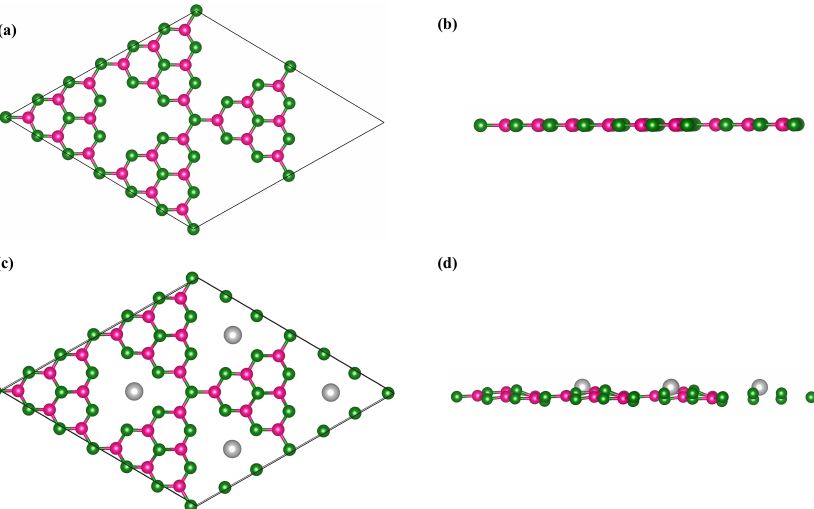
Figure 1. Optimized configurations of the g-C ( c , d ). Green, pink, and silver spheres represent N, C and Al atoms, respectively.